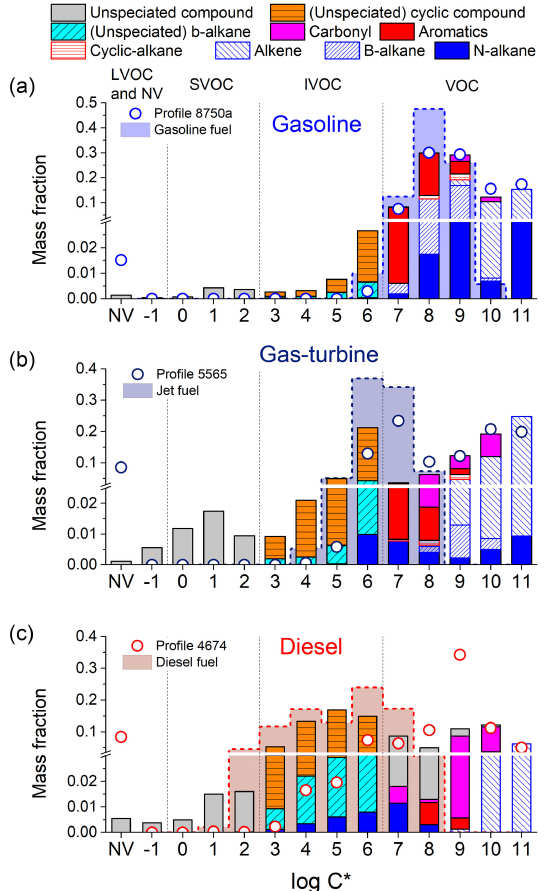
Figure 3. Median volatility distribution of organic emissions for (a) cold-start on-road gasoline, (b) gas-turbine (idle) and (c) on- road non-DPF diesel engines. The color shading indicates compo- sition. Shaded area indicated by dashed indicate distribution for un- burned fuel; dots indicate traditional source profiles from EPA SPE- CIATE database. The y axis has a broken scale to amplify the least volatile